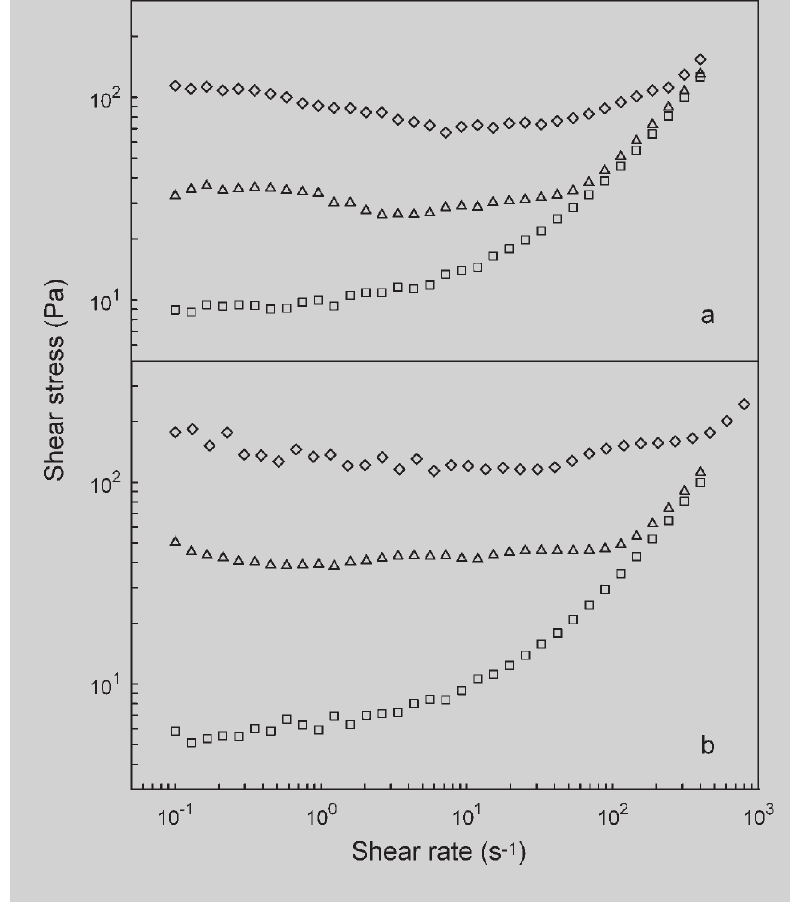
Figure 1: Data from controlled shear- rate experiment on the sus- pensions of (a) uncoated sili- ca and (b) silica coated with PANI (Electric field strength [kV mm -1 ] : · 0, Û 1, Ì